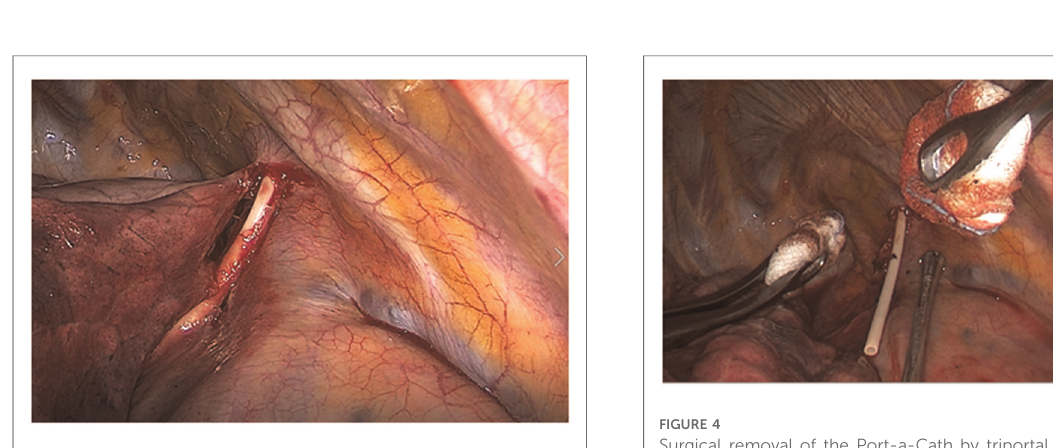
FIGURE 3 Surgical removal of the Port-a-Cath by triportal video-assisted thoracic surgery (VATS): visualization of the central venous catheter located in the pleural cavity, anteriorly to the right subclavian vessels, and running along the superior vena cava.